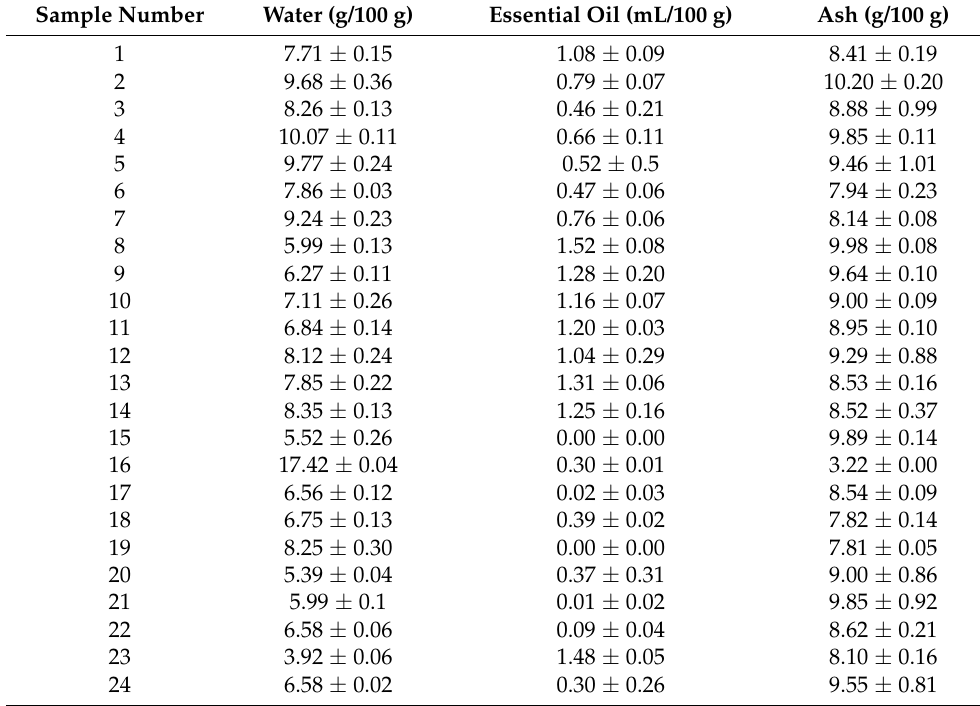
Table A1. Results of the NIR analysis for water, essential oils and